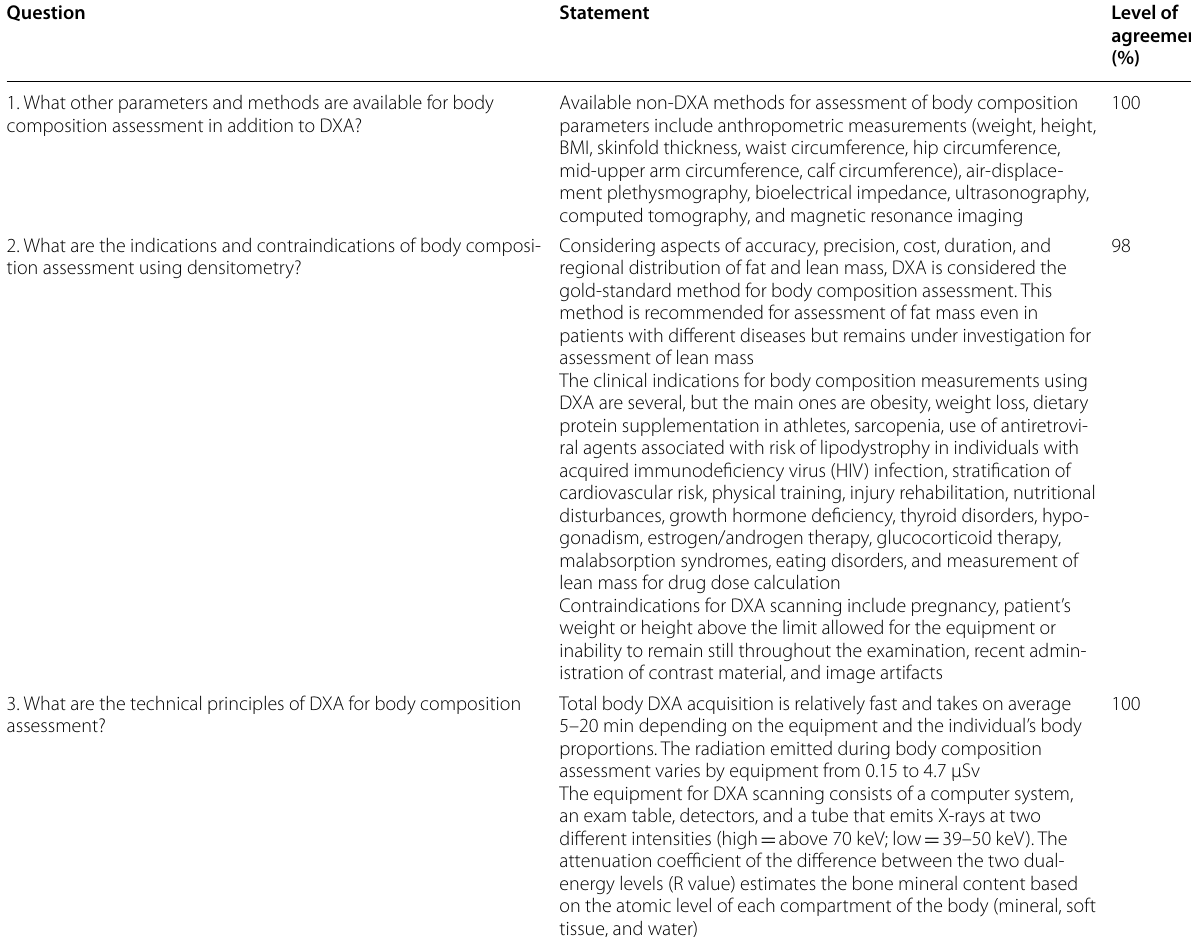
Table 1 Statements from the Official Position of the Brazilian Association of Bone Assessment and Metabolism (ABRASSO) regarding technical aspects of body composition measurements using dual‑energy X‑ray absorptiometry (DXA), along with the levels of agreement (interrater reliability) among the statement’s